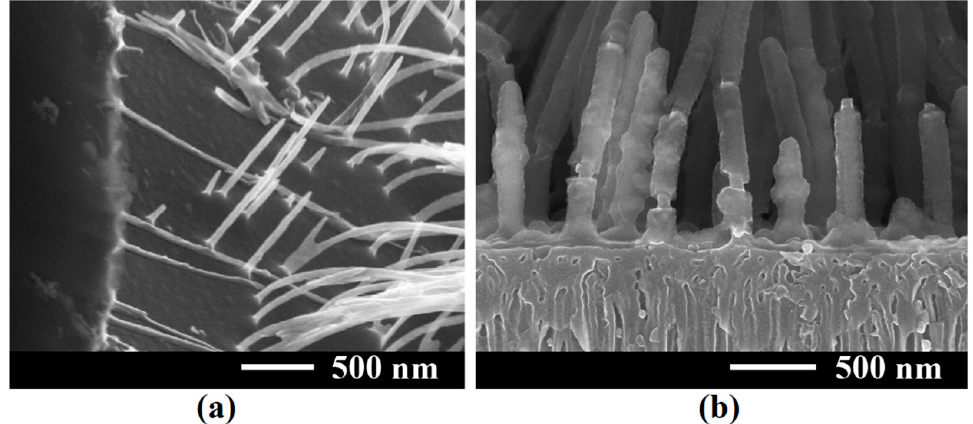
Figure 7. SEM cross-sectional image of: ( a ) InP nanowires obtained via fast electrochemical etching of InP substrates at 15 V for 3 s; ( b ) core–shell InP/Pt structure on porous InP.